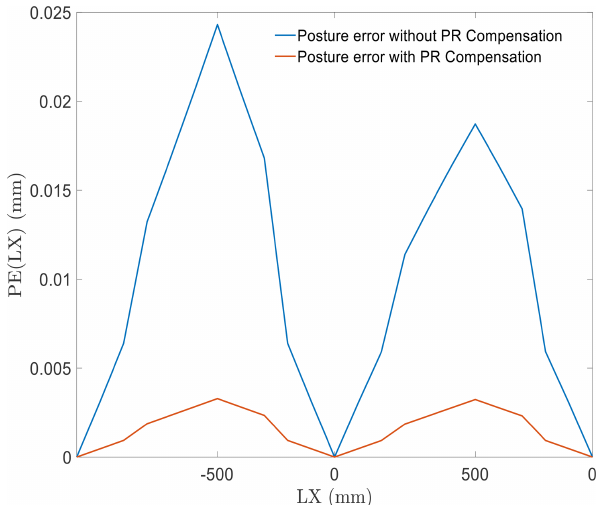
Figure 8. Comparison of posture errors in rotational motion around z axis.